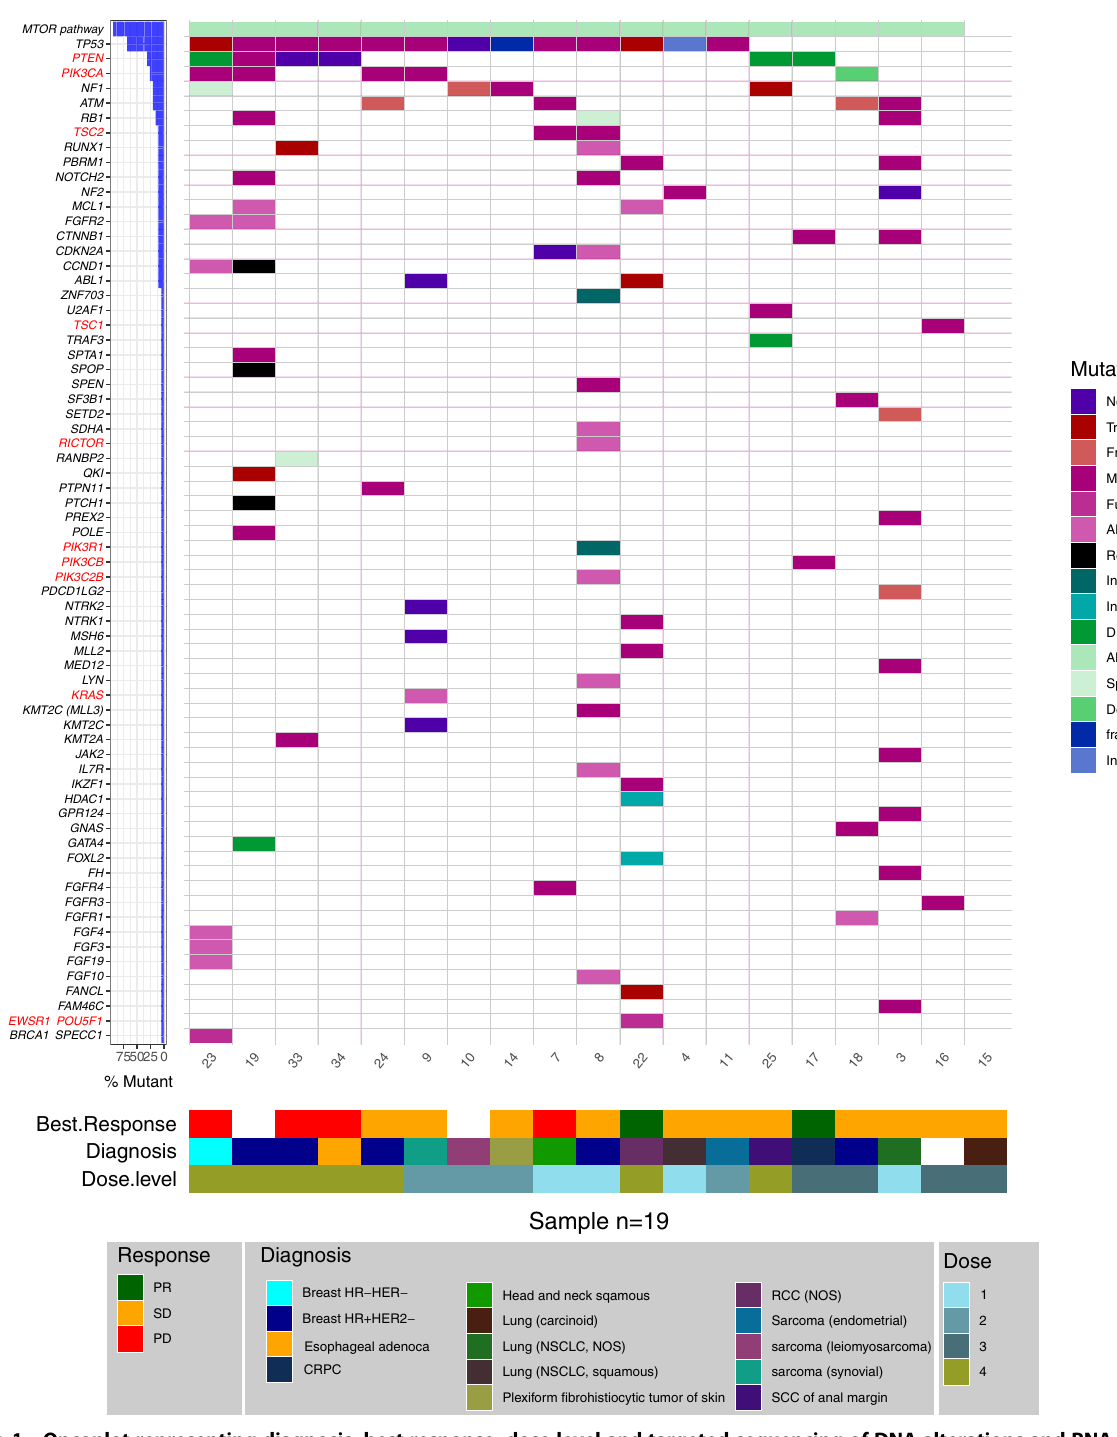
Fig. 1 Oncoplot representing diagnosis, best response, dose level and targeted sequencing of DNA alterations and RNA fusion products in enrolled patients. Highlighted in red are genes implicated in the mTOR pathway. Key: PR partial response, SD stable disease, PD progressive disease, HR hormone receptor, HER2 human epidermal growth factor receptor 2, CRPC castration resistant prostate cancer, NSCLC non-small cell lung cancer, RCC renal cell cancer, SCC squamous cell de fi cient tumors have been reported to have enhanced sensitivity rationale for the platinum-based combination 21 for our patient to the inhibition of mTOR pathways 22 . The hypothesized (Fig. 4) with mRCC. Downstream signaling pathways following the activation of downstream activation of mTOR signaling in our patient with receptor tyrosine kinase include the activation of the well-known mCRPC was the rationale for choosing this trial regimen for his RAF/MERK/ERK and the PI3K/AKT/mTOR pathways which is therapy. In a murine model, mTOR complex 2 seems to be controlled in part by the tumor-suppressor gene: PTEN . PTEN - required for the development of prostate cancer induced by Pten